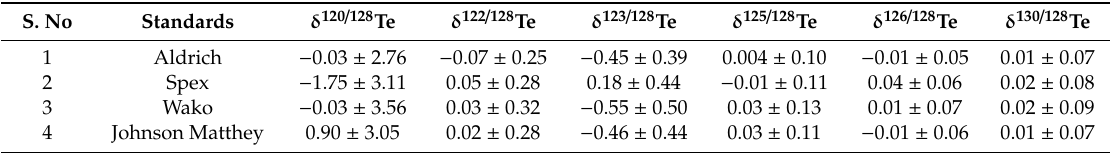
Table 2. Tellurium isotope data of terrestrial standards.